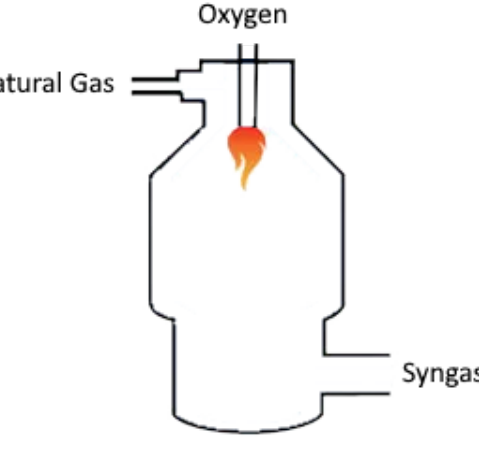
Figure 3. Traditional POX reactor.